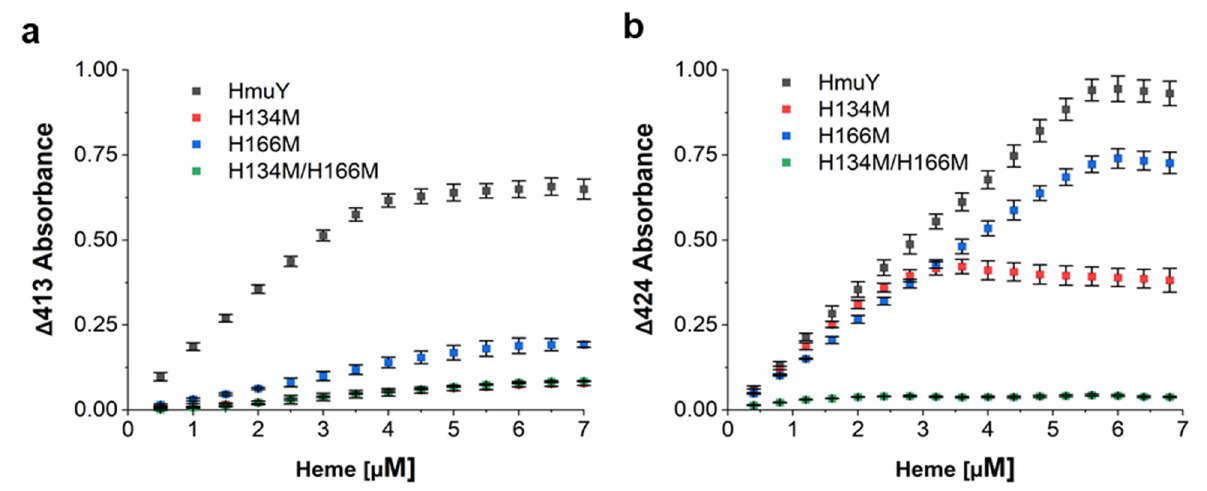
Figure 5. Heme binding ability to site-directed mutagenesis HmuY variants. Curves generated after titration of 5 µ M protein samples with heme by measuring UV-visible difference spectra between protein + heme and heme-only samples. Samples analyzed under ( a ) air (oxidizing) conditions or ( b ) reduced by sodium dithionite. Results shown as mean ± SD from two independent experiments.